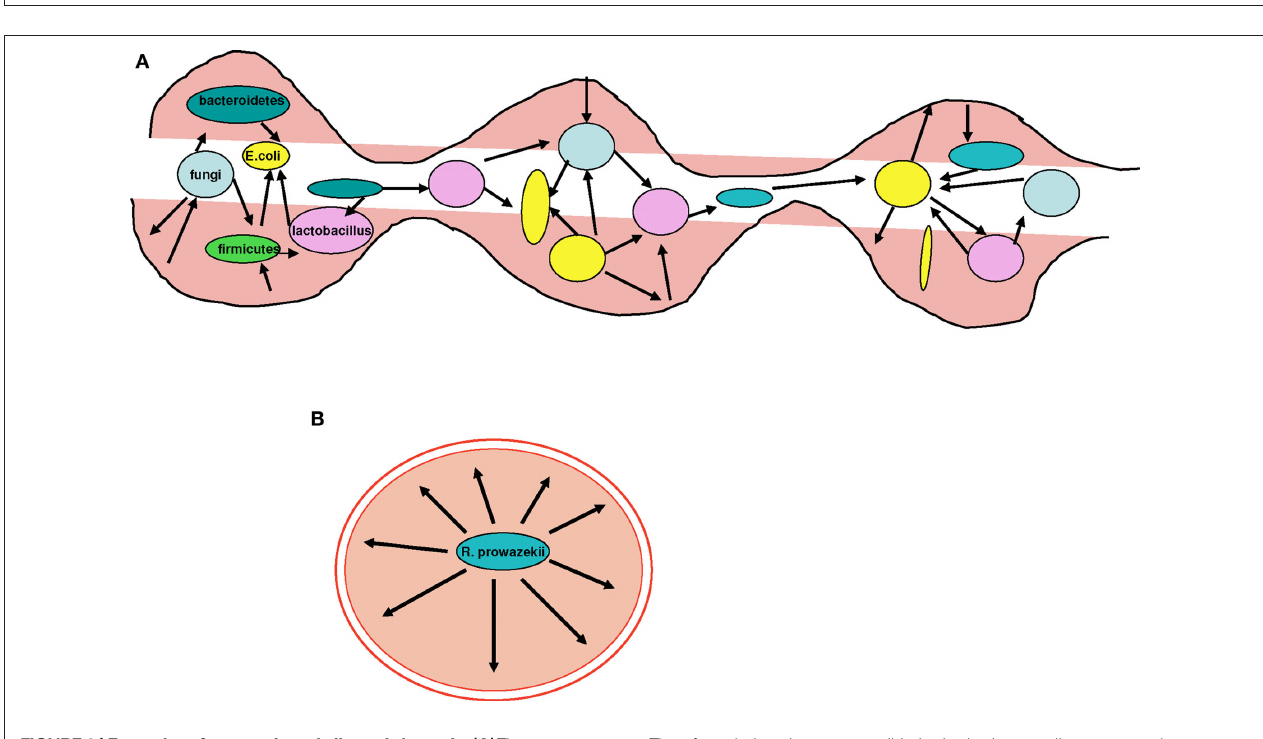
Figure 7 | The resistome. Sympatric species have a higher resistance capacity compared to allopatric species, which are more sensitive to the action of antibiotics. (A) Gut microbes unaffected by antibiotics possess resistance genes, probably acquired through HGT. (B) Specialized species are more sensitive and may not resist some antibiotics. Their resistome is limited because of their isolation and their inability to exchange genes. Blue arrows represent resistance genes.